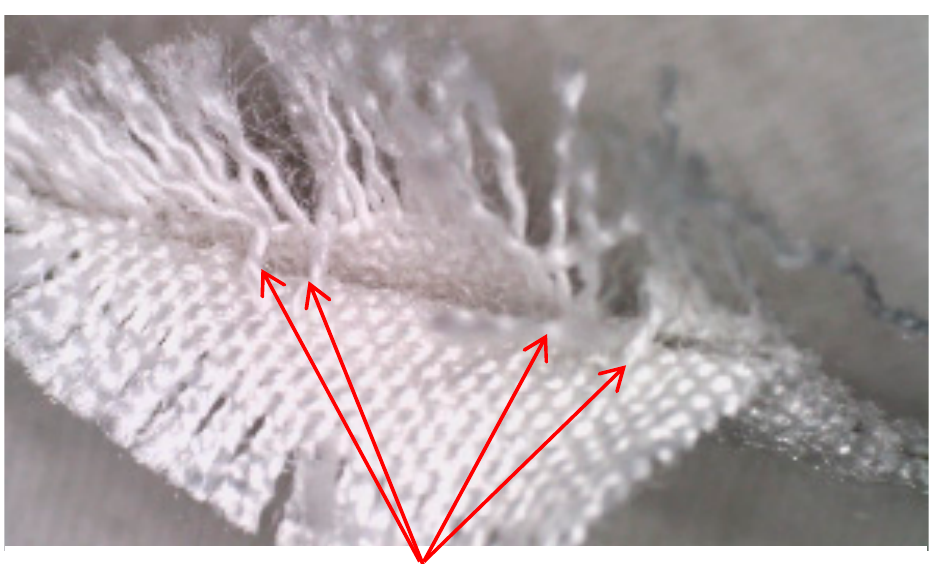
Figure 3. Cross-section of a 3D-woven fabric, marked “1pp” (magnification 20×).